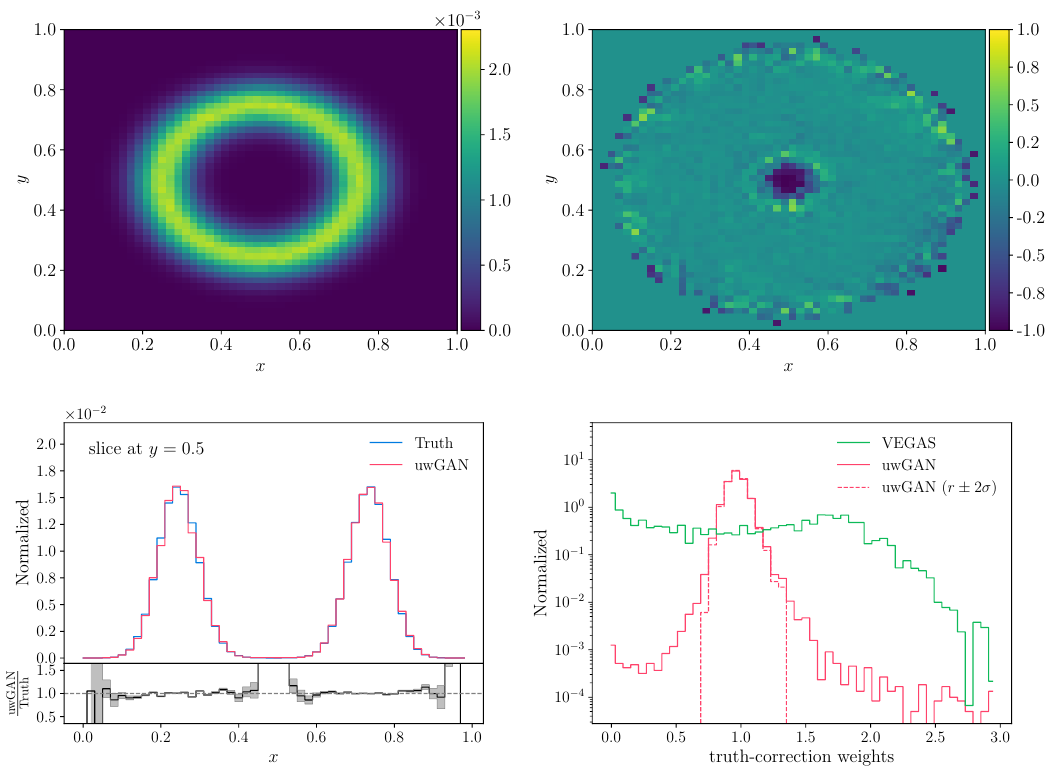
Figure 3: Results for the 2-dimensional Gaussian ring showing the truth data (upper left), the asymmetry between truth and uwGAN (upper right), a 1-dimensional slice at y = 0.5 (lower left), and the comparison of the truth-correction for uwGANned events with Vegas events (lower right). The dotted curve includes the bulk region − 2 σ , r + 2 σ ] r ∈ [ r 0 0